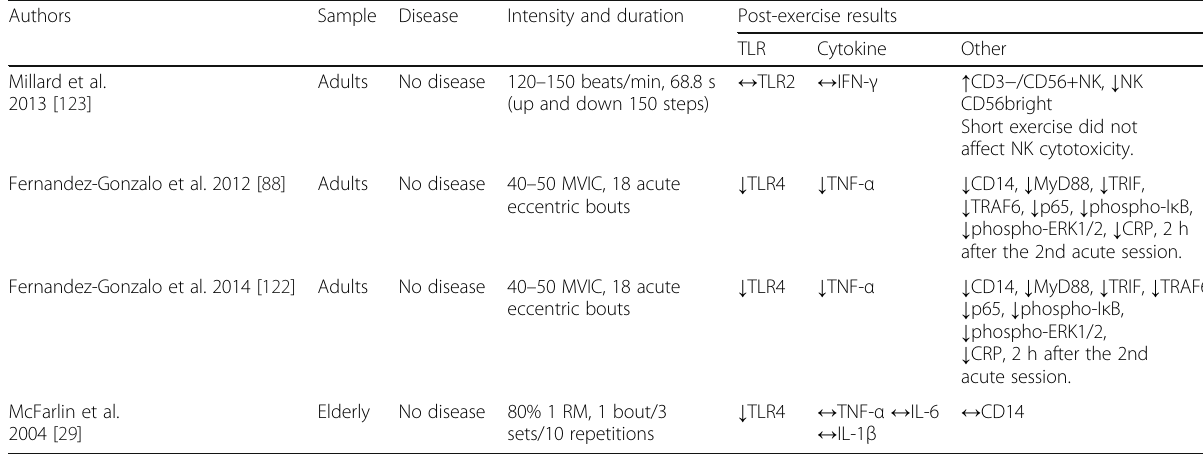
Table 5 Modulation of TLR2 and TLR4 after acute resistance exercise